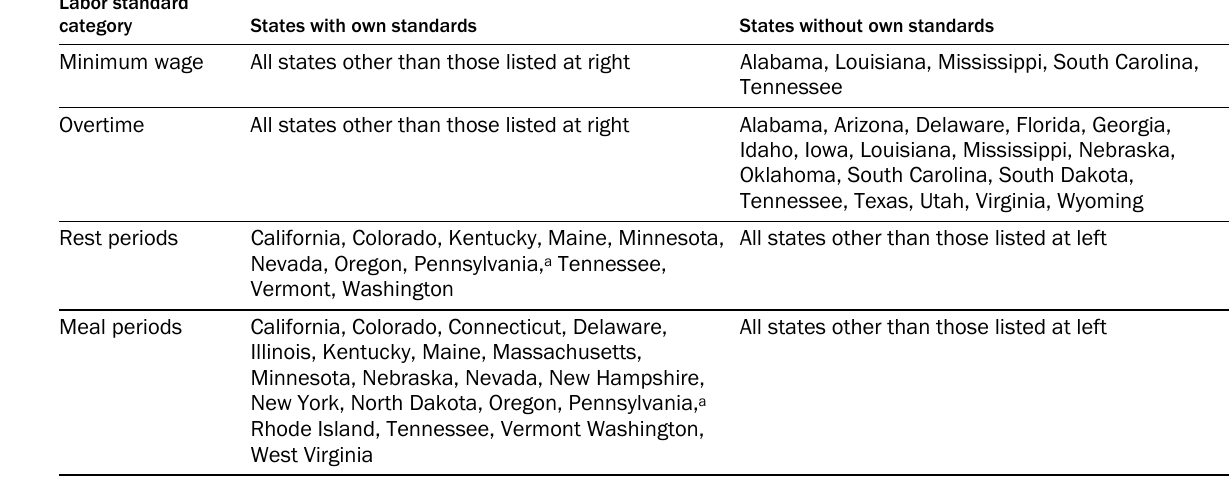
Table 1. States With and Without Their Own Labor Standards, by Category of